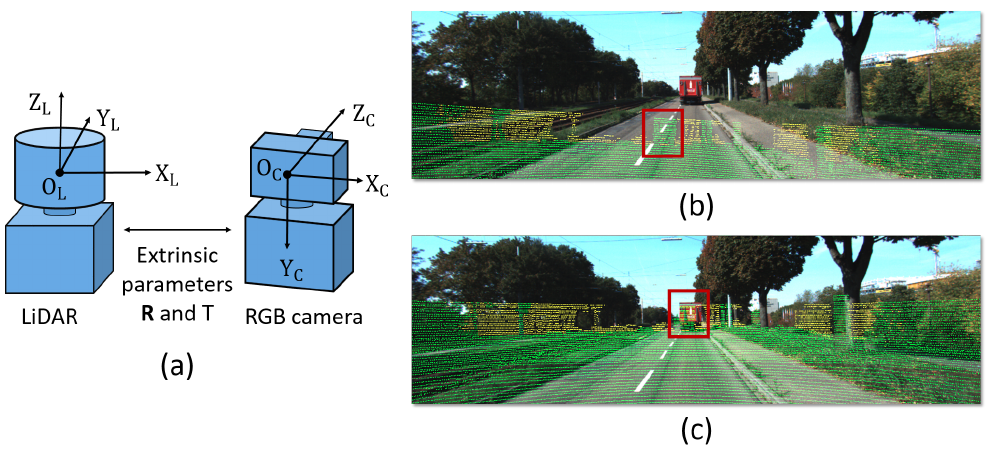
Figure 2. The task and significance of online extrinsic calibration on LiDAR-camera system. ( a ) the model of LiDAR-camera system; ( b ) inaccurate alignment of LiDAR point cloud and RGB image with R 0 and T 0 ; ( c ) LIA-SC-Net predicts accurate ∆ R and ∆ T , thus obtaining the precise alignment result. The projected LiDAR point cloud with pseudo color dependent on LiDAR intensity is used for visualization. After calibration, RGB pixels and LiDAR points of the vehicle in the red box are correctly